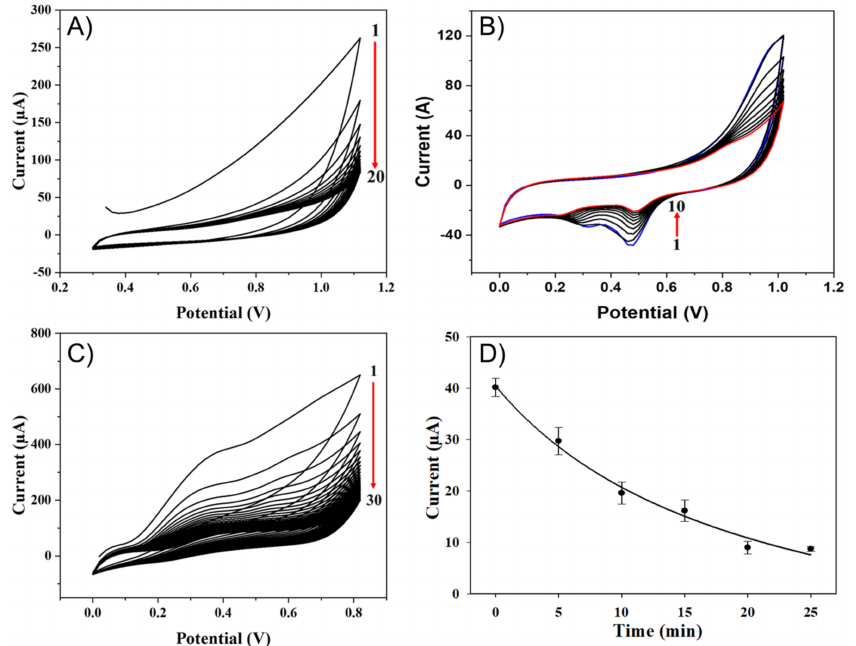
Figure 1. Optimization of the sensor fabrication steps: ( A ) for electrode cleaning, cyclic voltammetry curves showing that the increasing number of cyclic voltammetry cycles (up to 20) leads to a stable curve; ( B ) cyclic voltammetry curves for electrodeposition of AuNPs, where the blue and red-colored curves show before and after electrodeposition of AuNPs, respectively; ( C ) electropolymerization of MIP, where cyclic voltammetry curves show that the increasing number of cycles (up to 30 cycles) leads to a stable curve; ( D ) the rebounding of the tetracycline on the cavities takes up to 25 min until the saturation of the